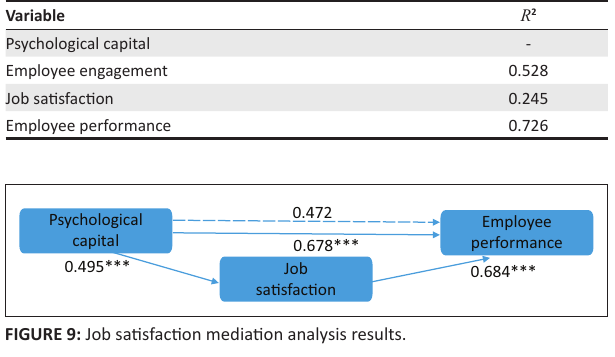
TABLE 4: Squared multiple correlations ( R 2 ).